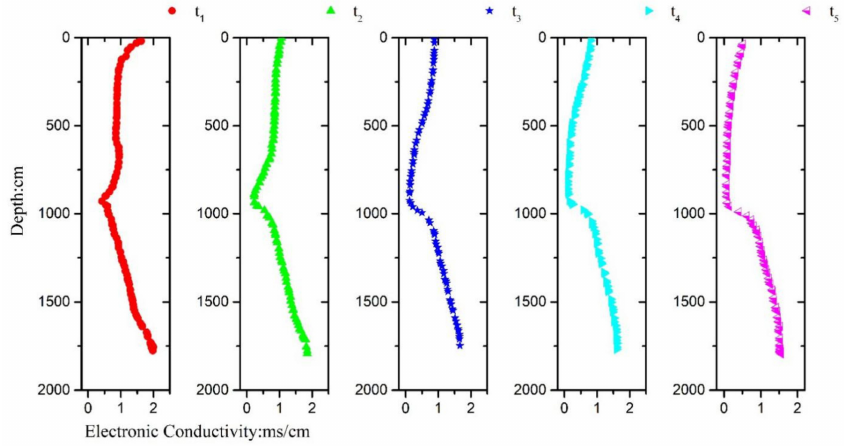
Figure 8. EC profiles of P9-9 at different